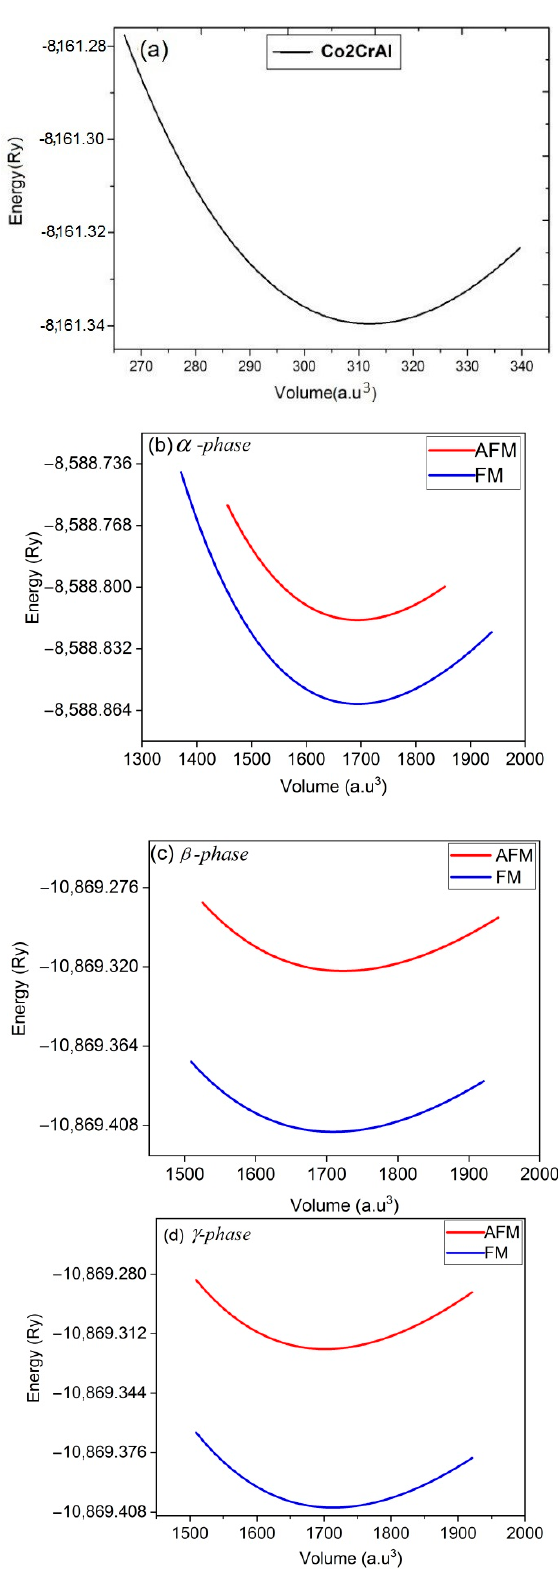
Figure 2. E-V curves of Co 2 CrAl compound in the: ( a ) bulk, ( b ) α , ( c ) β and ( d ) γ Heuslerene phases. Minimum points approve that all structures are statically stable.